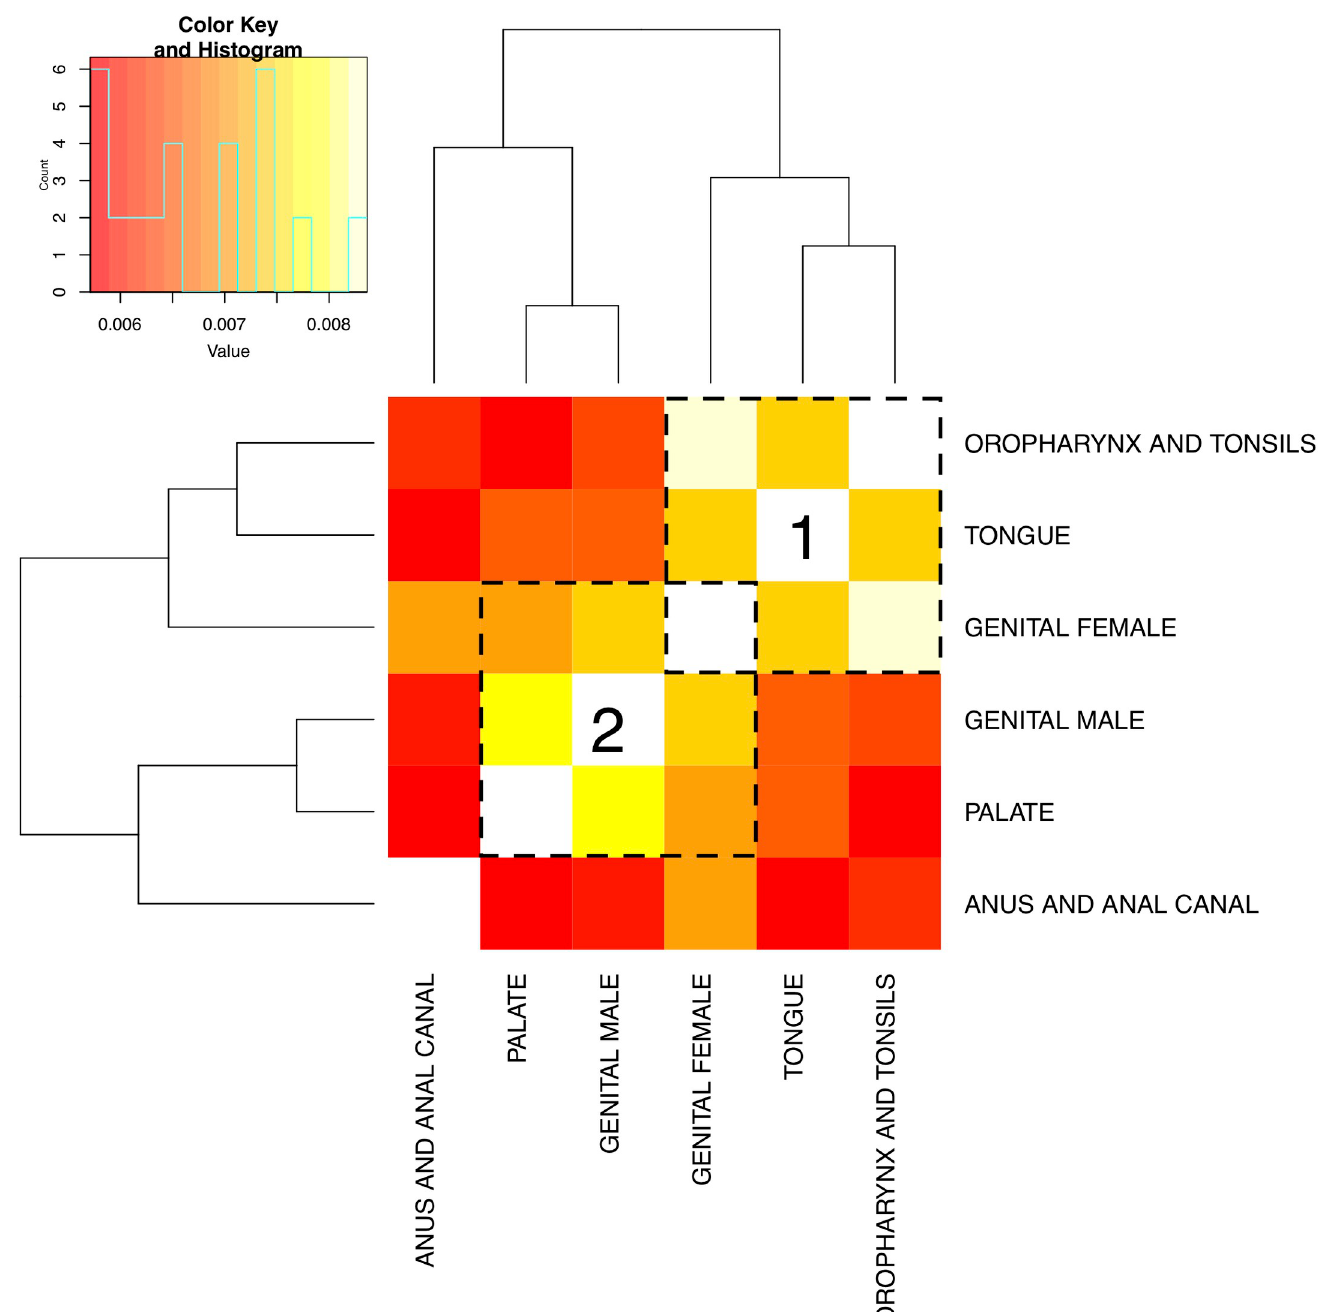
Fig 6. Task relationship learned by MSSL for task split Topography group 1 . Lighter values indicate stronger relationships. Four groups of cancer sites were found: 1) tonsil and cervix uteri ; 2) tonsil , cervix uteri , base of tongue , anus and anal canal , and vulva ; 3) vulva , penis , and palate ; and 4) vagina and oropharynx . Groups are highlighted in the